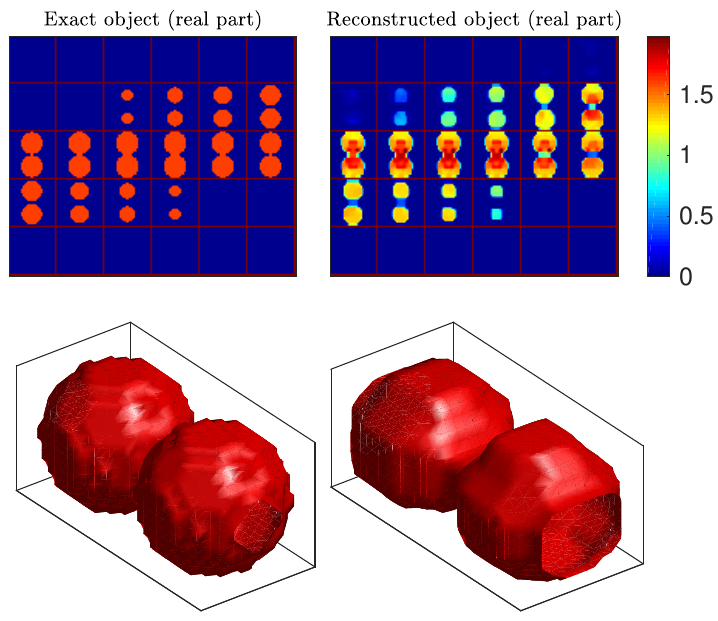
Figure 4. Reconstructed contrast function for the TwoSpheres object. Top: 30 horizontal slices of the true object ( left ) and the 30 slices of the reconstructed object ( right ). Bottom: isosurfaces of the true object discretized on the reconstruction grid ( left ), and of the reconstructed object ( right ), for contrast value 1.